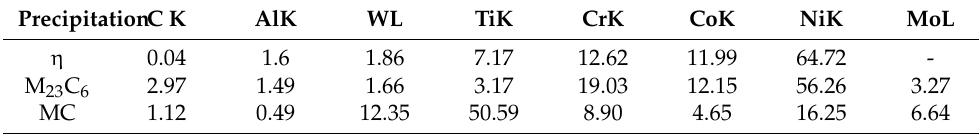
Table 2. Mass percentage compositions of precipitations (wt%). PrecipitationC K